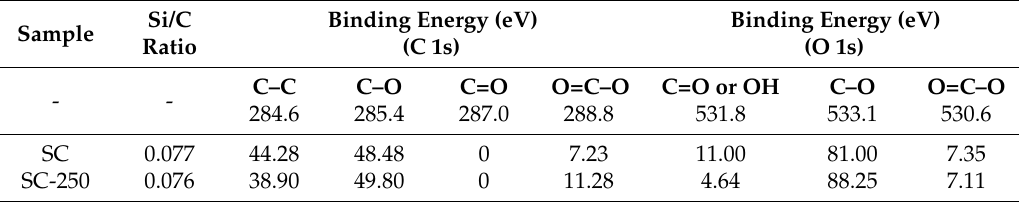
Table 2. X-ray photoelectron spectroscopy (XPS) results for C 1s (284.6–288.8 eV) and O 1s (530.6–531.8 eV) regions, Si/C ratio and relative concentration (%) of functional groups for SC and SC-250 samples.